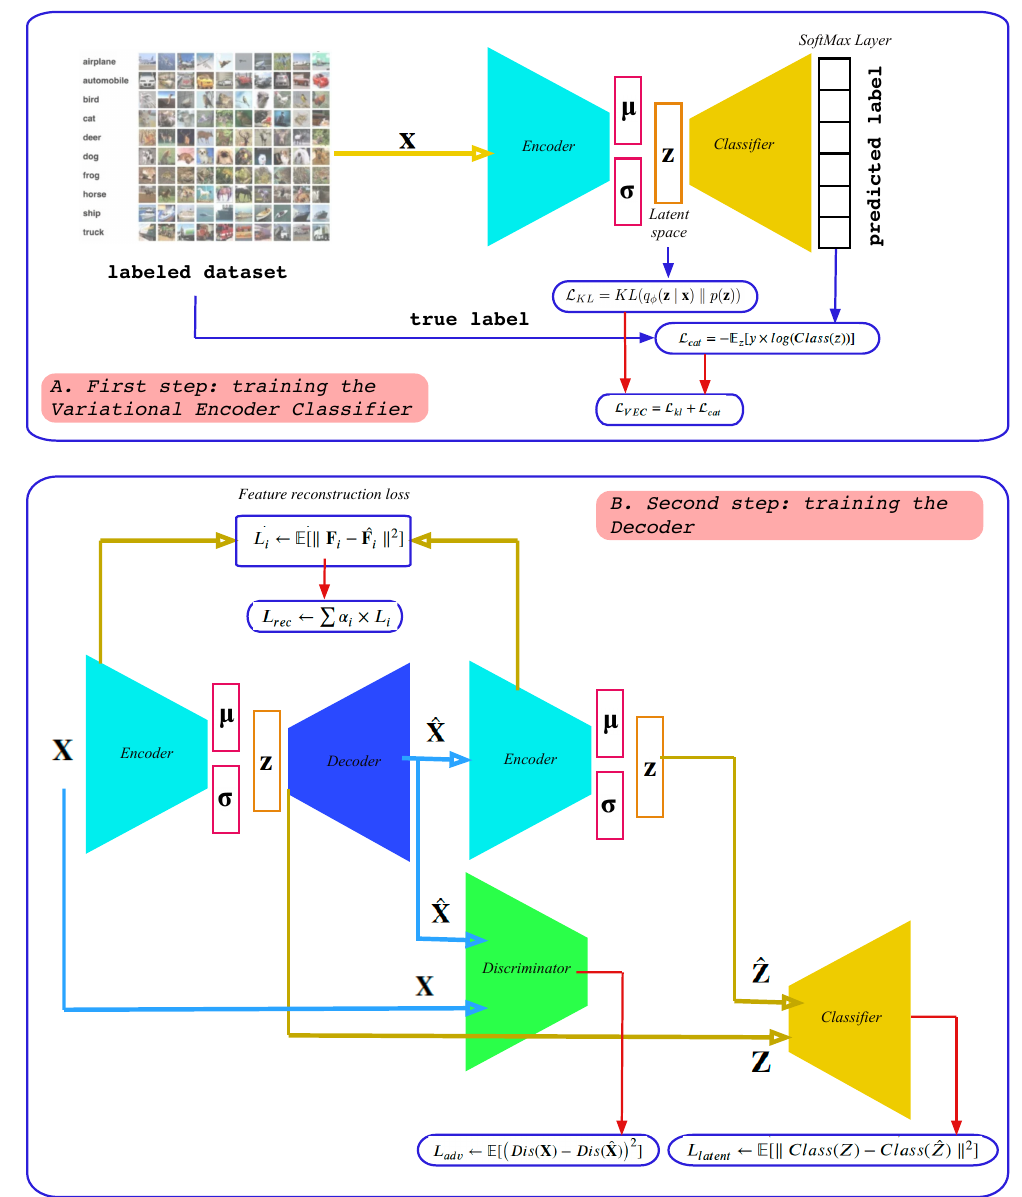
Figure 3. The framework of the proposed